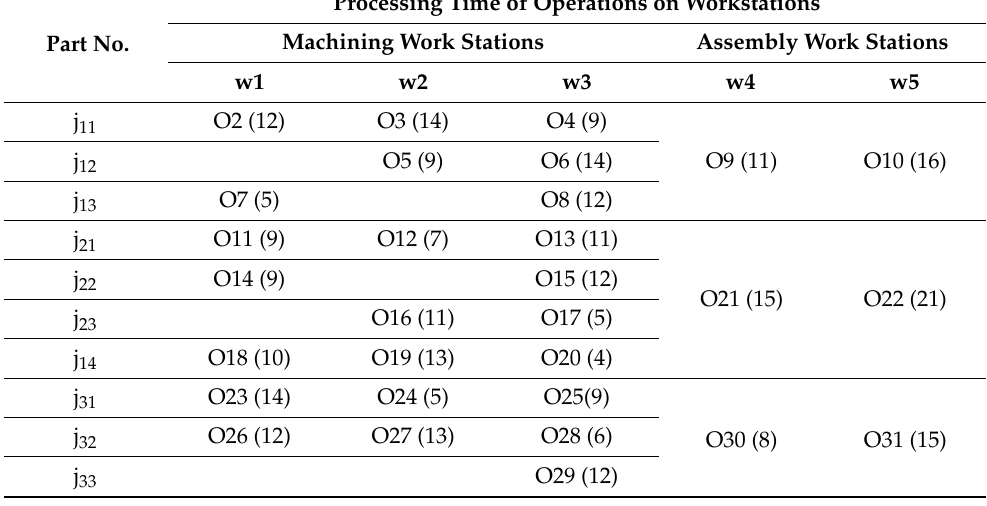
Table 4. Numerical